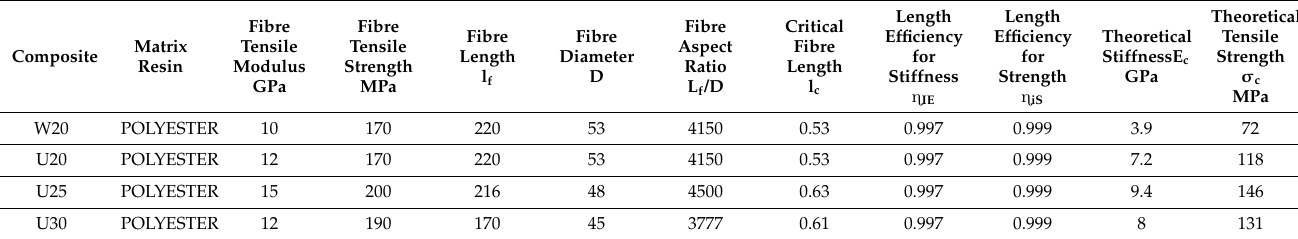
Table 4. Physical, mechanical properties of jute fibre used in this